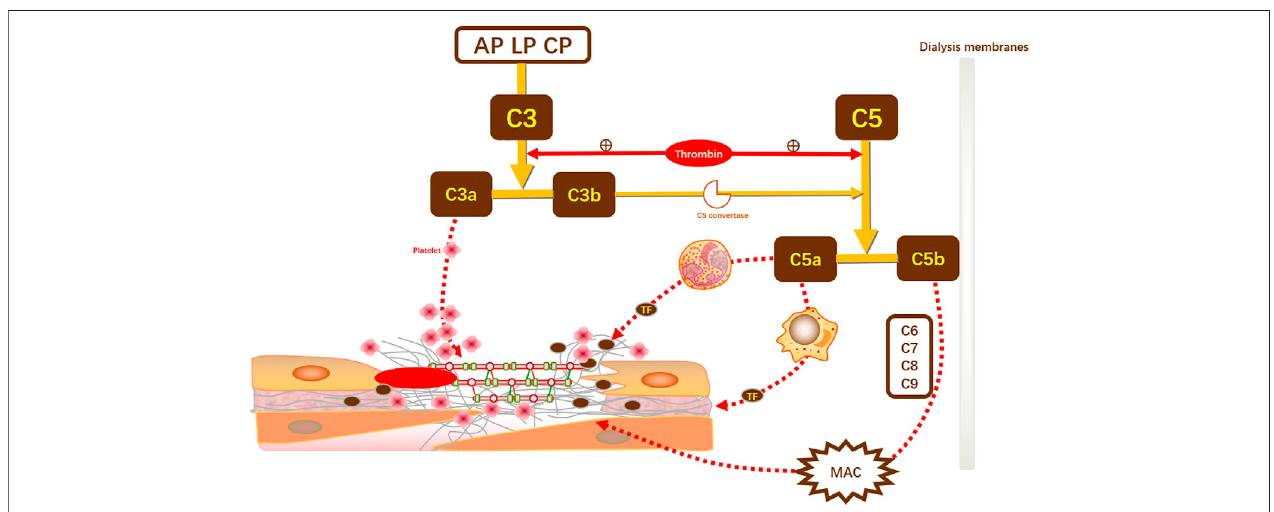
FIGURE 1 | Complement activation promotes coagulation. C3, the initiator of the complement activation pathway, can be cleaved into effector components, namely C3a and C3b. In CKD-induced complement activation, C3a directly promotes coagulation by enhancing platelet aggregation and adhesion. Meanwhile, C3b promotesthesynthesisofC5convertasetoinduceC5cleavagetoproduceC5aandC5b.C5adirectlystimulatesneutrophilsandmonocytestoincreasetheexpression of TF and thus induce thrombosis. In renal replacement therapy, C5b comes into contact with the dialysis membrane and, together with multiple complements (C6 – C9), mediates the production of MAC and induces coagulation. In turn, coagulation secondary to complement activation can amplify complement and coagulation activationthroughpositivefeedbackfromthrombinonC3cleavage.TF,tissuefactor;MAC,membraneattackcomplex;AP,alternativepathway;LP,lectinpathway;CP, classical